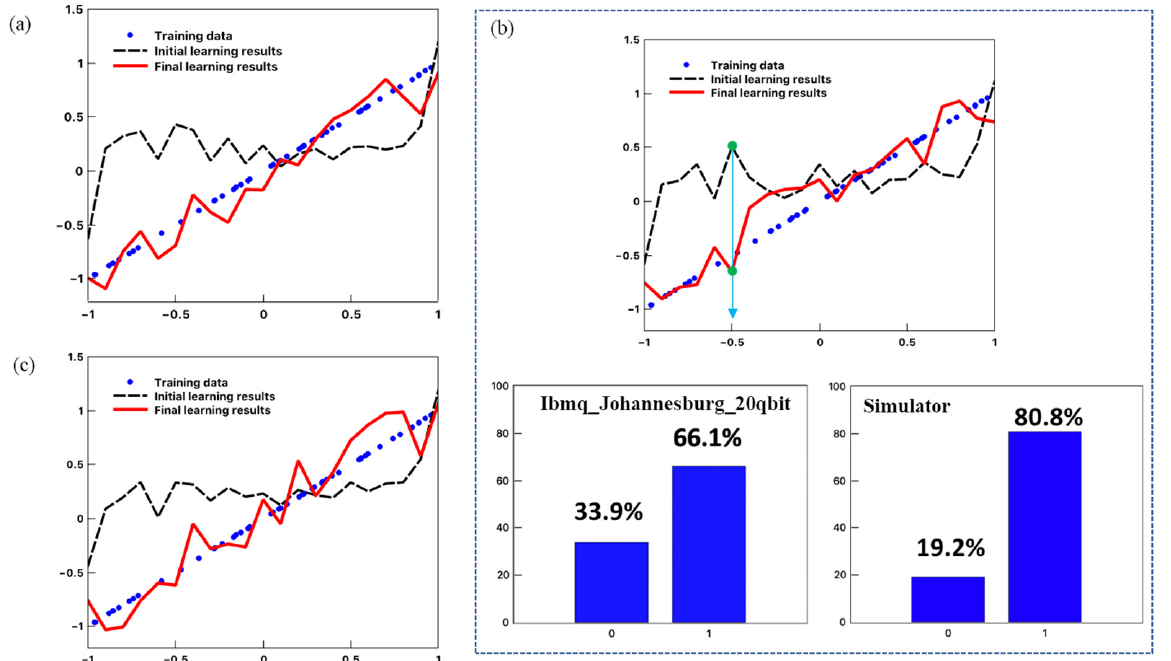
Figure 10. Results of linear regression using a real machine. Regression of target function f ( x ) = x . ( a ) The number of measurements M shot of the quantum circuit is 2048 times. ( b ) M shot = 4096. Here the probability comparison for x = 0.5 is shown. The left one is the measurement of IBM Q computer and the right one is derived from the quantum circuit simulator. ( c ) M shot = 8192.